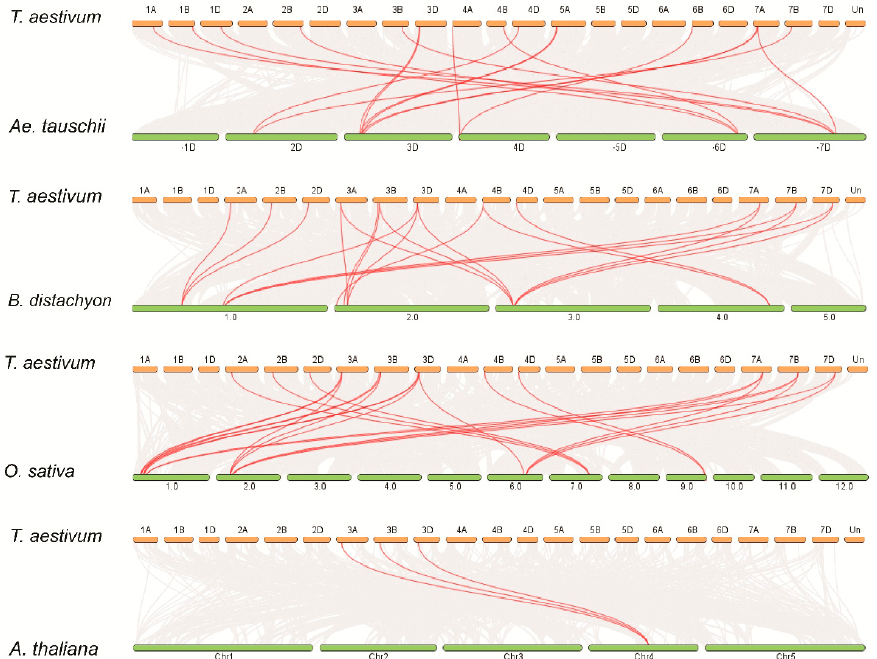
Figure 3. Syntenic relationships of TaBZR genes between Aegilops tauschii , Brachypodium distachyon , Oryza sativa and Arabidopsis thaliana . The gray lines in the background represent the collinear blocks within Triticum aestivum and other plant genomes, while the red lines highlight the syntenic BZR gene pairs. gene pairs.